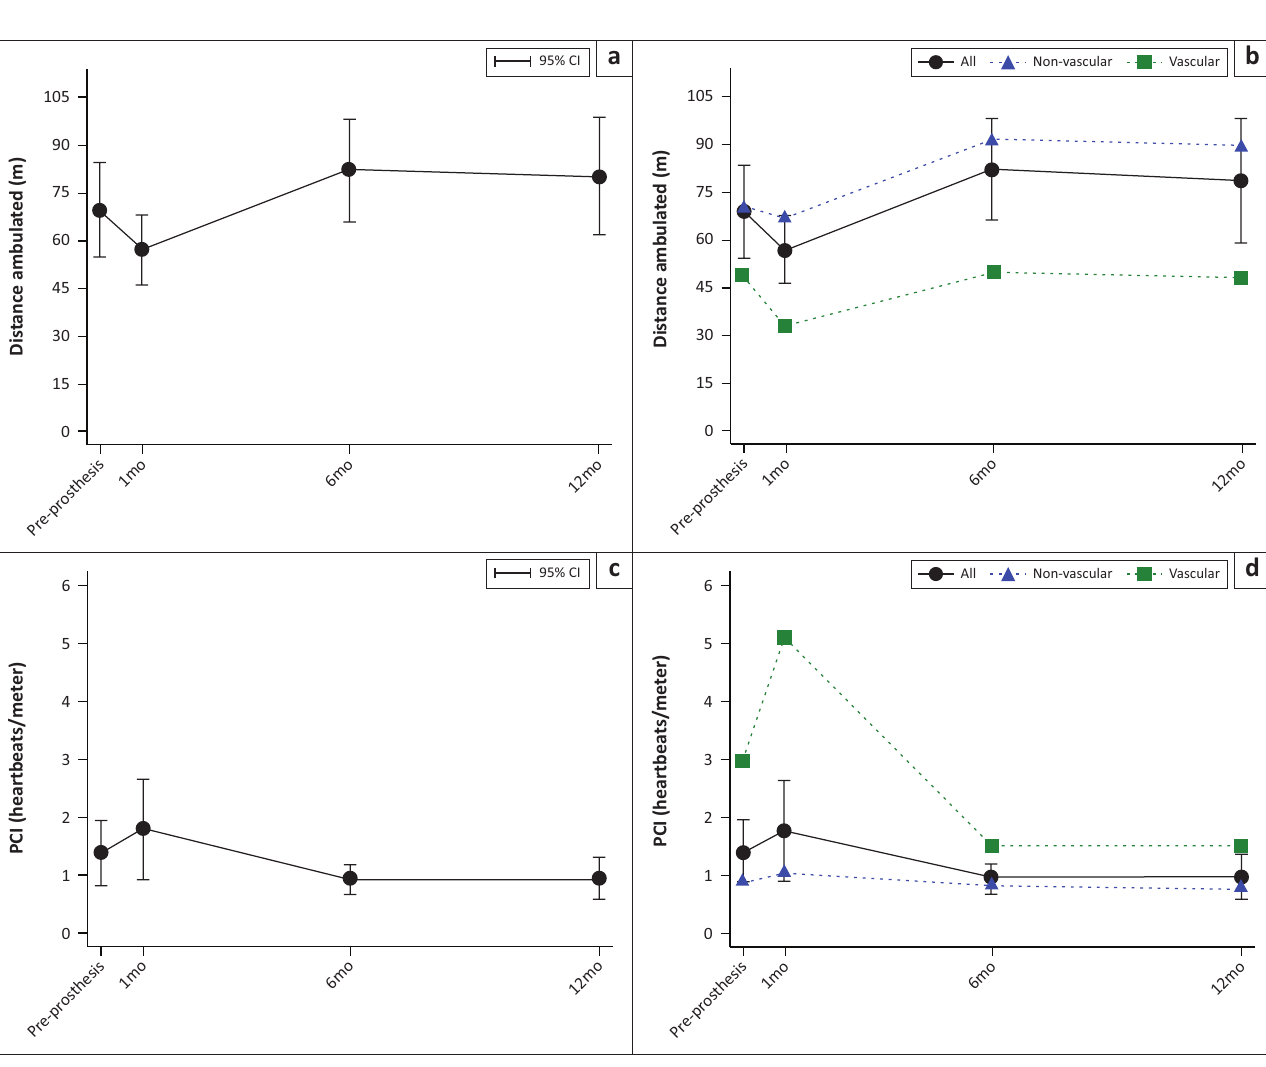
Note: Functional outcome scores for all patients are shown in black, for patients who underwent transfemoral amputation for trauma, tumour or infection are shown in blue and for patients who underwent transfemoral amputation for diabetes or vascular disease are shown in green. 95 % confidence intervals (95 % CI) are reported. p -values were calculated using one-way repeated measures ANOVA and post hoc pairwise comparison with Bonferroni correction between pre-prosthesis and each subsequent follow-up timepoint. FIGURE 4: Functional outcomes before amputation, at the casting visit before prosthesis fitting, 1, 6 and 12 months after prosthesis fitting: (a) 2-minute walk test scores at the casting visit before prosthesis fitting (pre-prosthesis) and at 1 month (1 mo), 6 months (6 mo) and 12 months (12 mo) follow-up after prosthesis fitting; (b) 2-minute walk test scores for patients separated by the reason for amputation at pre-prosthesis, 1 mo, 6 mo and 12 mo; (c) Physiologic Cost Index (PCI) at pre-prosthesis, 1 mo, 6 mo and 12 mo and (d) PCI for patients separated by the reason for amputation at pre-prosthesis, 1 mo, 6 mo and 12